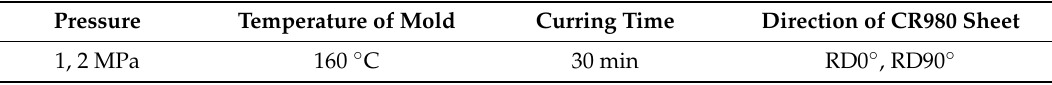
Table 4. Parameters of the V-bending test of the CFRP/CR980 hybrid composite.